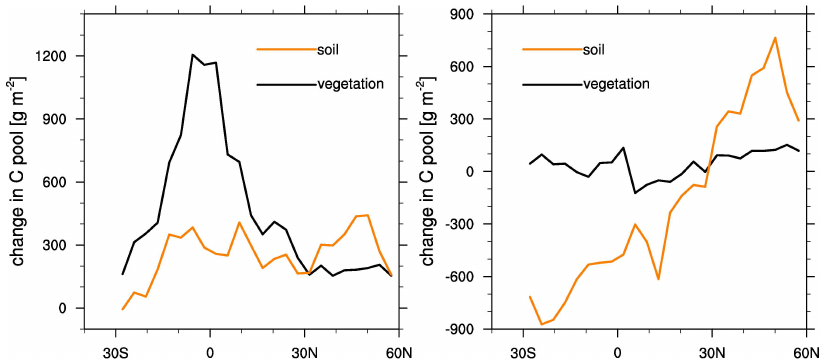
Fig. D1. The difference in C stored in vegetation (orange) and soil (black) in the C-only simulation as zonal means during the periods 1860–2100 (left) and 2100–2400 (right). Shown are differences between the means of the years 1860–1889 (2070–2099) and 2070–2099 (2370–2399) for C in vegetation and soil. Soil includes C in litter and soil organic matter.